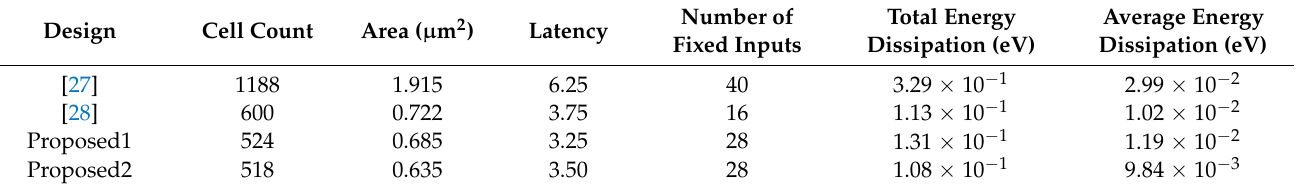
Figure 22. Simulation results of the proposed G(8, 4) circuits. ( a ) The first G(8, 4) and ( b ) the second G(8, 4). Table 9. Comparisons of the performance and energy dissipation for alternative (8, 4) polar encoders.